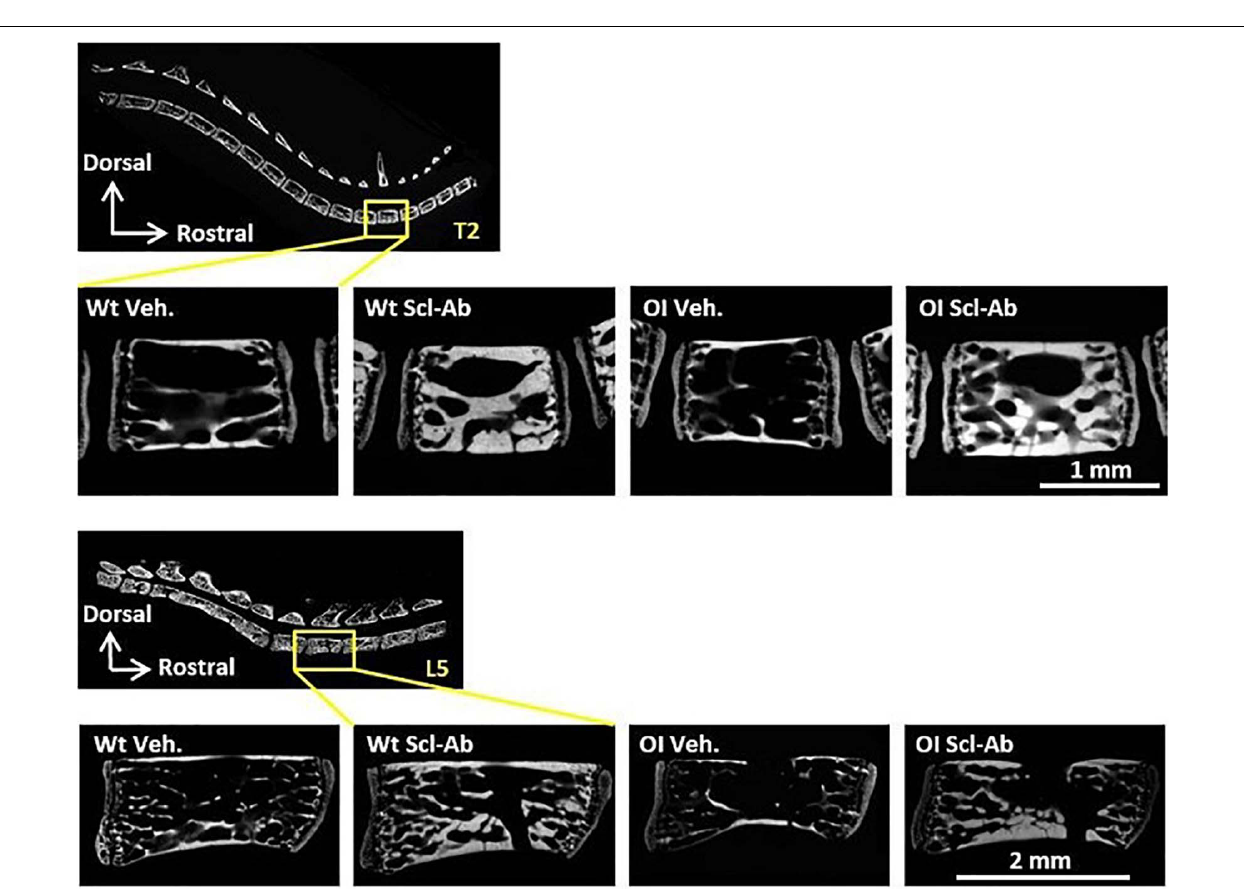
Frontiers in Genetics |